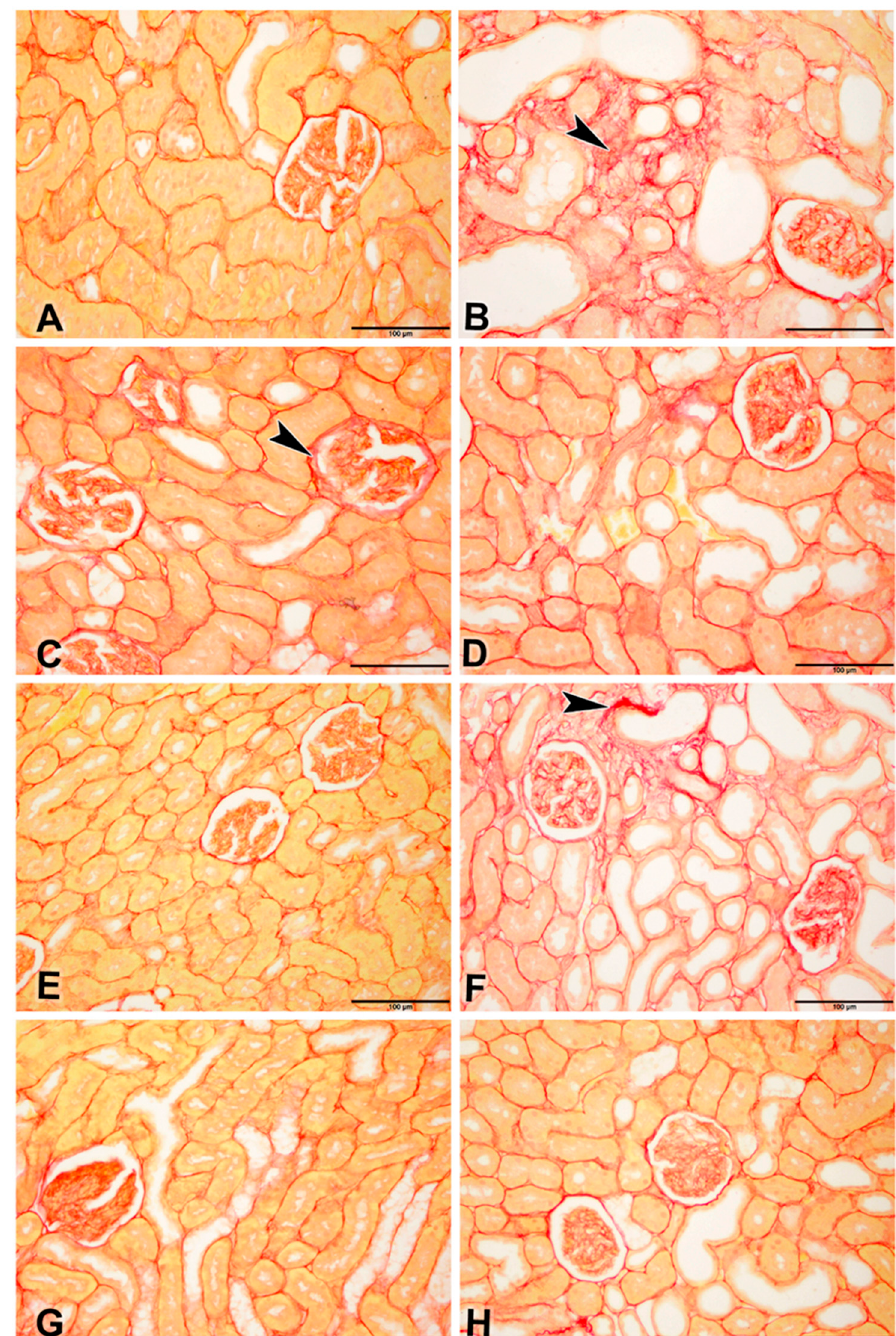
Figure 4. Representative photographs of Picro-Sirius red staining on sections of renal tissues (Bar = 100 μ m) from control rats and rats treated with adenine (A), streptozotocin (STZ), and metformin (MF), alone or in combination. ( A ) Control and ( E ) MF groups showed normal kidney architecture and histology. ( B ) adenine ( A , C ) STZ showed stained fibrotic areas fibers (arrowheads) and yellow non-collagen structures. ( D ) A + STZ groups showed changes in normal kidney architecture and histology. ( F ) The A + MF group showed fibrotic areas fibers (arrowheads). ( G ) STZ + MF and ( H ) A + STZ + MF groups showed an improvement in the histologic appearance and a significant decrease in fibrotic areas fibers when compared with the STZ and A + STZ group, respectively.